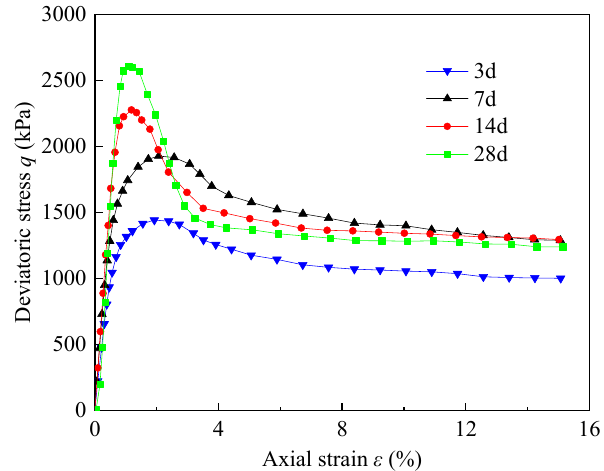
Figure 5. Stress–strain curves of the cemented soil under a 400 kPa confining pressure (cement content: 18%).